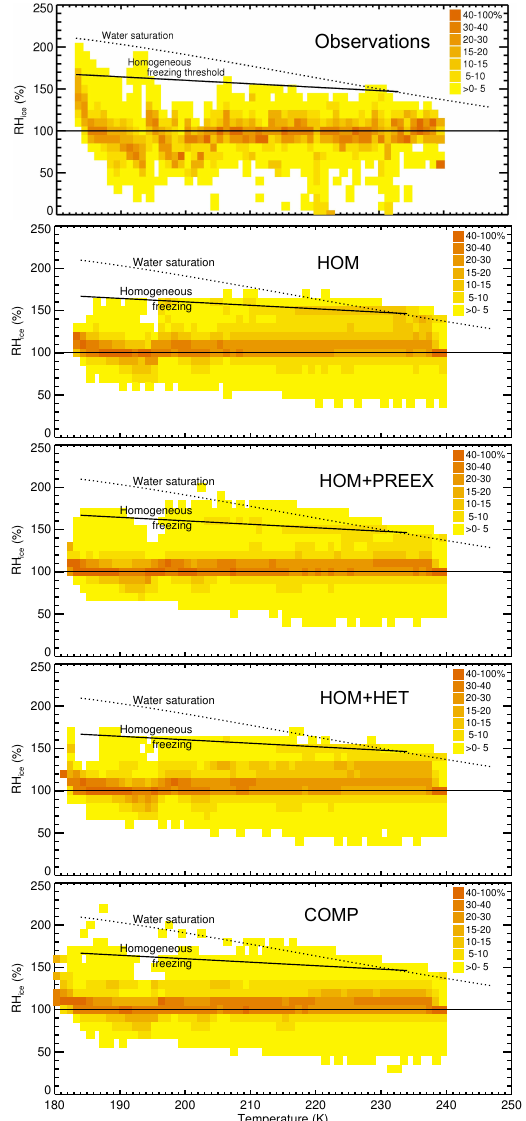
Fig. 7. Frequency of occurrence of RH i inside of cirrus vs. T . The uppermost panel depicts 9.7h of airborne in situ measurements. All other panels show model results of the simulations HOM, HOM + PREEX, HOM + HET and COMP. Model results are sam- pled every 6h for January of the year 2000. All data are sorted into 1K T bins. The black solid line indicates the homogeneous freezing threshold and the dotted line represents water saturation (RH w =